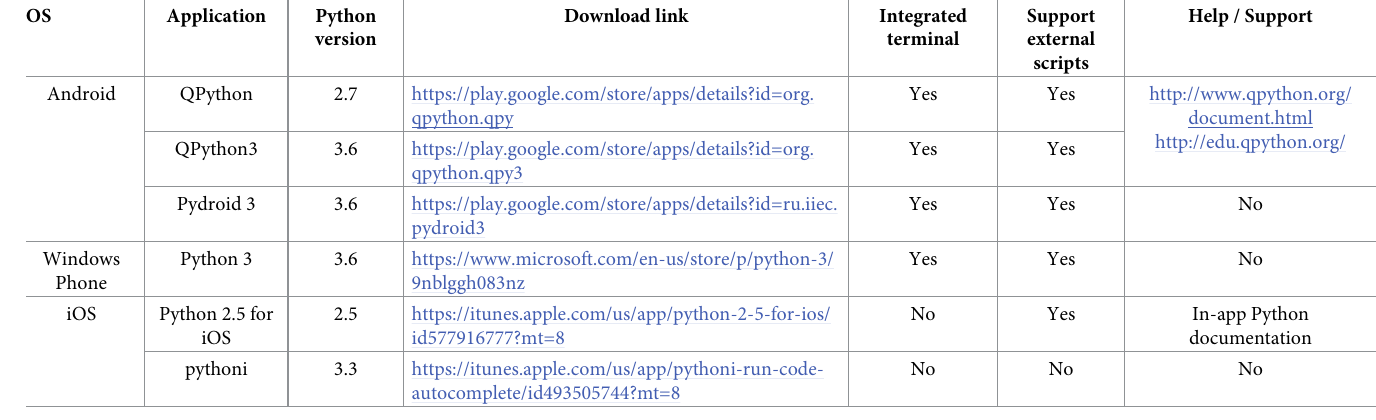
Table 2. Characteristics of suggested smartphone applications for running Python. Selected applications classified by OS and Python version. All programs are free and available in English. OS